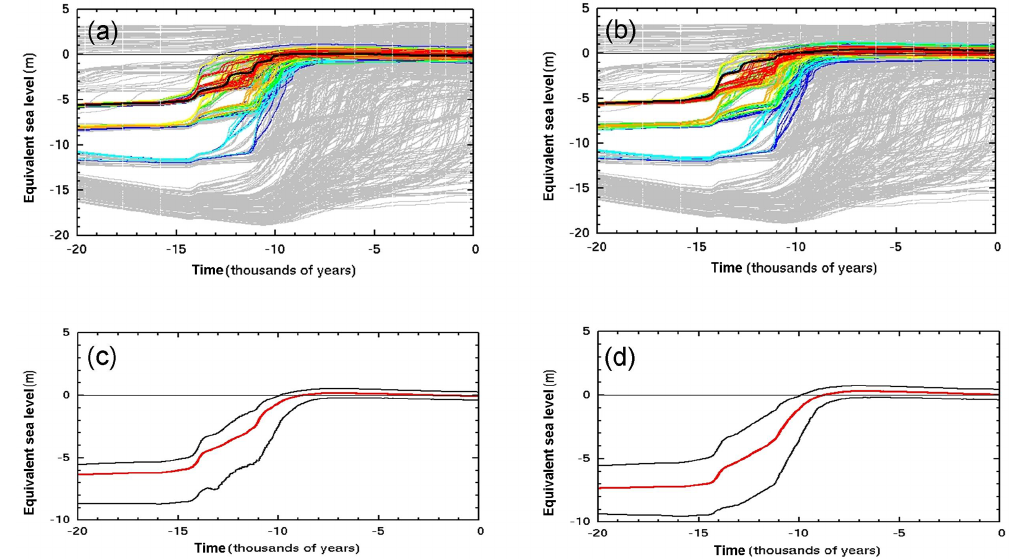
Figure C4. Equivalent global-mean sea-level contribution (ESL) relative to modern vs. time as in Fig. 5. (a) Scatterplot of all 625 individual runs in the LE, using close-to-Gaussian scoring approach (a) (Sect. 2.4, Appendix B). (b) As (a) except using the more heuristic approach (b) (Sect. 2.4, Appendix B), exactly as in Fig. 5. (c) Score-weighted mean and one-sided standard deviations, using close-to-Gaussian scoring approach (a). (d) As (c) except using the more heuristic approach (b), exactly as in Fig. 5.